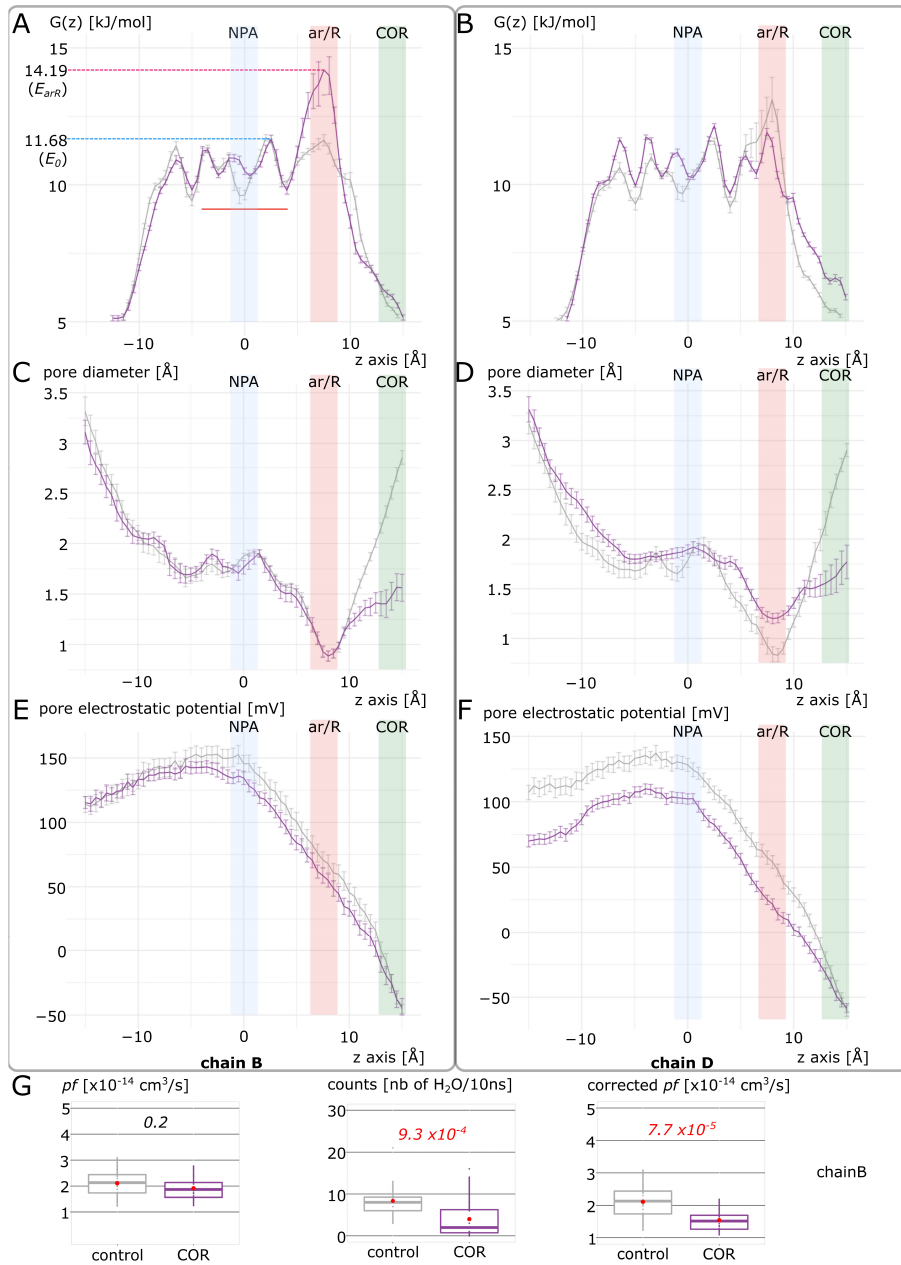
Figure 5. Differences in electrostatic and steric contributions to water permeability hindrance by cortisol. “Control” condition (in gray) is compared to “COR” condition (in purple) for chain B ( A , C , E ) and chain D ( B , D , F ). ( A , B ) Water free energy profiles inside the pore. ( C , D ) Pore diameter. ( E , F ) Pore electrostatic potential. The NPA motifs corresponding to the center of the channel are indicated in blue, the ar/R constriction in red and the extra-cellular vestibule where the cortisol is docked to the porine in green. ( G ) Estimation of ar/R constriction contribution to water permeability hindrance in chain B through Dk constant pf correction. From left to right: pf, number of water permeation events (crossing the entire membrane section), corrected pf. The two conditions were compared with non-parametric Mann–Whitney test for pf and counts and with parametric t -test for corrected pf. p values are indicated in